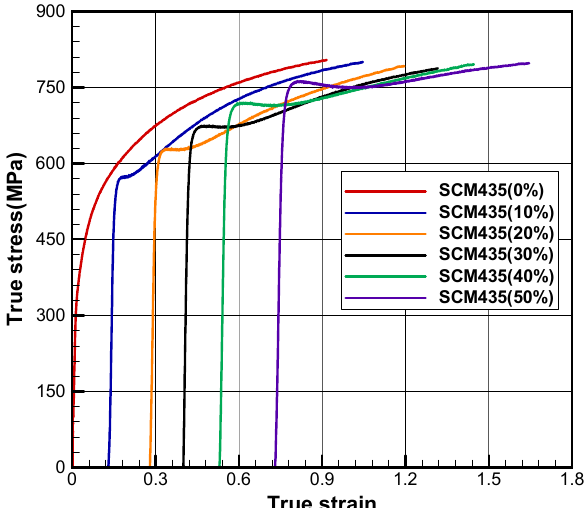
Figure 4. Bauschinger effect occurring in cylinder compression test of the drawn specimens [65].